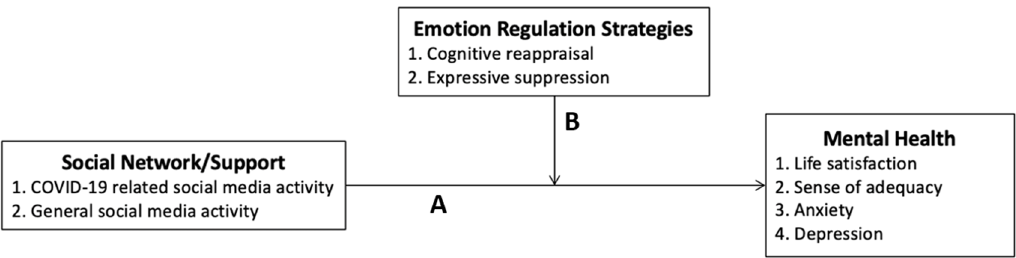
Figure 1. The conceptual framework of relationships among people’s social media activities, emotion- regulation strategies, and mental health